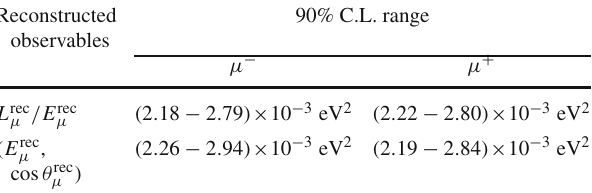
Table 5 The expected 90% C.L. allowed ranges for | (cid:3) m 2 analyses using L rec μ / E rec μ and ( E rec μ , cos θ rec μ ) distributions of the U/D ratio, with 500 kt · yr exposure. The true value of | (cid:3) m 2 2 . 46 × 10 − 3 eV 2 , and the other oscillation parameters θ 12 , θ 23 , θ 13 , and (cid:3) m 2 are varied over their currently allowed ranges, and systematics 21 are taken into